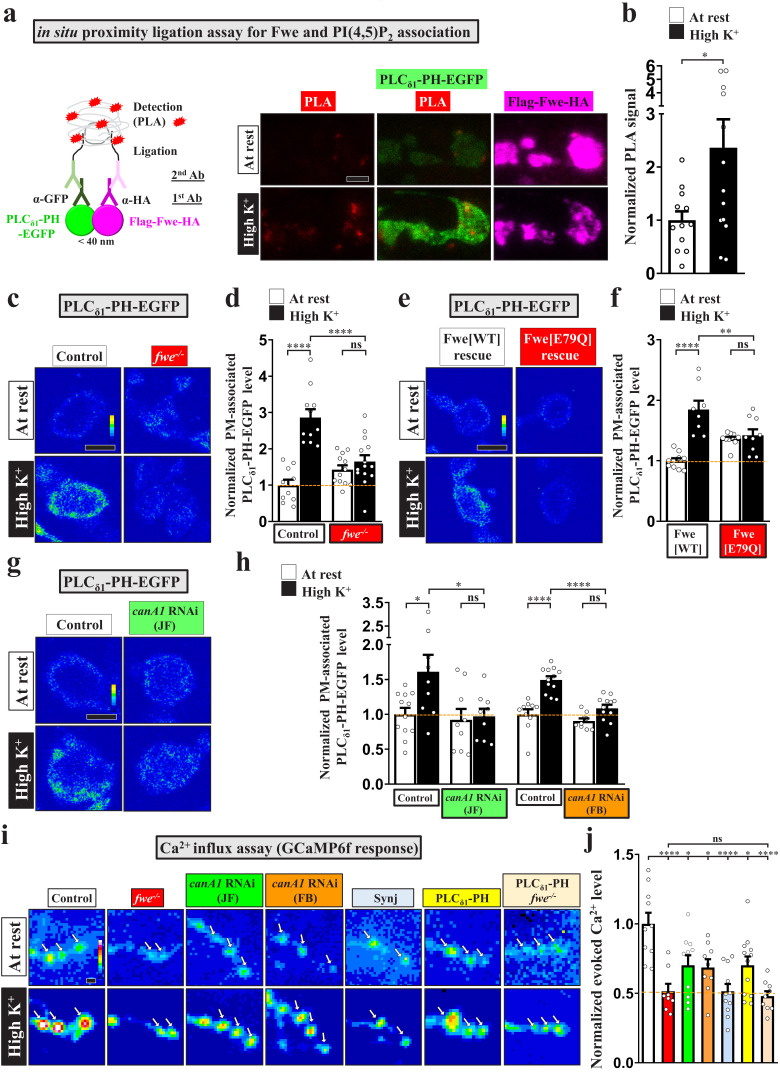
Fwe and PI(4,5)P2 form a positive feedback loop to establish PI(4,5)P2 microdomains.(a–b) Fwe and PLCδ1-PH-EGFP interact upon intense stimulation. (a) (Left) A schematic for PLA. (Right) Z-projected confocal images of fwe mutant boutons co-expressing Flag-Fwe-HA and PLCδ1-PH-EGFP (nSyb-GAL4/UAS-Flag-fwe-HA/UAS-PLCδ1-PH-EGFP in fweDB25/DB56 at 25°C). After resting condition or high K+ stimulation, the boutons were subjected to PLA. α-GFP and α-HA stained for PLCδ1-PH-EGFP (green) and Flag-Fwe-HA (magenta), respectively. PLA signals (red). (b) Quantification data for PLA signal intensities, normalized to the value of the resting condition. (c–f) Loss of Fwe or its Ca2+ channel activity perturbs PI(4,5)P2 microdomain formation. (c and e). (c) Single-plane confocal images of the boutons neuronally expressing UAS-PLCδ1-PH-EGFP in fweDB25/+ (control) or fweDB25/DB56 at 25°C. The boutons were subjected to resting condition or high K+ stimulation, followed by α-GFP immunostaining. Quantification data for PLCδ1-PH-EGFP staining intensity are shown, normalized to the value of the resting condition of controls (d). (e) Single-plane confocal images of the boutons neuronally expressing lexAop2-PLCδ1-PH-EGFP using vglut-lexA in wild-type Fwe rescue boutons (vglut-lexA/lexAop2-PLCδ1-PH-EGFP, nSyb(w)-GAL4/UAS-flag-fwe-RB-HA in fweDB25/fweDB56 at 25°C), or FweE79Q rescue boutons (vglut-lexA/lexAop2-PLCδ1-PH-EGFP, nSyb(w)-GAL4/UAS-flag-fweE79Q-RB-HA in fweDB25/fweDB5 at 25°C). When the weak nSyb(w)-GAL4 driver drove low expression of UAS-fwe transgenes, this binary system (vglut-lexA/lexAop2-PLCδ1-PH-EGFP) was used to produce detectable levels of PLCδ1-PH-EGFP in boutons. Quantification data for PLCδ1-PH-EGFP staining intensity are shown, normalized to the value of the resting condition of Fwe-rescued boutons (f). (g–h) canA1 RNAi knockdown impairs PI(4,5)P2 microdomain formation. Single-plane confocal images of the boutons co-expressing UAS-PLCδ1-PH-EGFP with UAS-RFP (control), UAS-canA1-RNAi (TRiP.JF01871), or UAS-canA1-RNAi (FB4) using nSyb-GAL4. The larvae were reared at 25°C. After resting condition or high K+ stimulation, the boutons were stained with α-GFP. (h) Quantification data for PLCδ1-PH-EGFP staining intensities, normalized to the value of the resting condition of controls. (i–j) Blockade of the PI(4,5)P2 microdomains attenuates Fwe Ca2+ conductance. (i) Snapshot Ca2+ images of the boutons (arrows) expressing lexAop2-GCaMP6f using vglut-lexA. The larvae of control (w1118), fwe mutant (fweDB25/DB56), canA1 RNAi (JF) (nSyb-GAL4/UAS-canA1-RNAi (TRiP.JF01871)), canA1 RNAi (FB) (nSyb-GAL4/UAS-canA1-RNAi (FB4)), Synj overexpression (nSyb-GAL4/UAS-synj), PLCδ1-PH-APEX2-HA expression (vglut-lexA/LexAop2-PLCδ1-PH-APEX2-HA), or fwe mutant expressing PLCδ1-PH-APEX2-HA (vglut-lexA/LexAop2-PLCδ1-PH-APEX2-HA in fweDB25/DB56) were reared at 25°C. Imaging was taken in the fifth minute for one minute after high K+ (2 mM Ca2+) stimulation. (j) Quantification data for evoked Ca2+ level, normalized to the value of controls. Evoked Ca2+ levels are shown as the increase in GCaMP6f fluorescence under high K+ stimulation. Individual data values are shown in graphs. p values: ns, not significant; *p<0.05; **p<0.01; ****p<0.0001. Mean ± SEM. Scale bar: 2 µm. Statistics: Student t-test (b). One-way ANOVA with Tukey’s post hoc test (d, f, h, j).
Figure 3—source data 1.Source data for Figure 3.